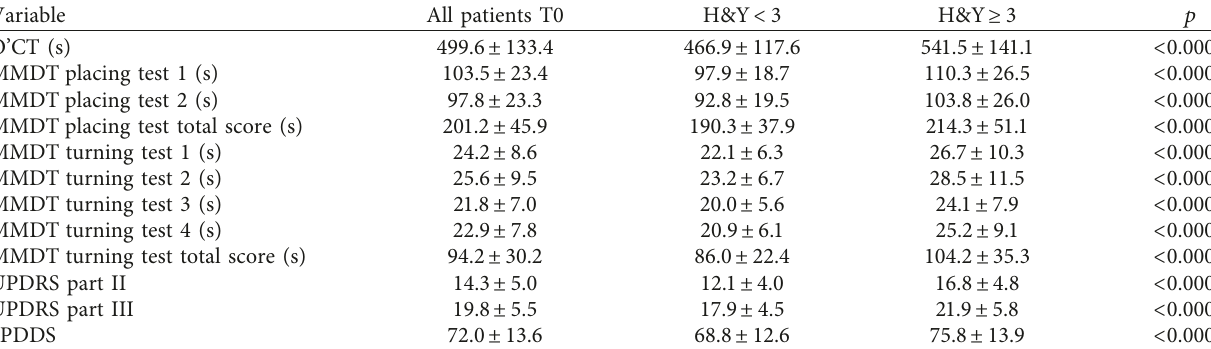
Table 2: Baseline values of the clinical, motor, and functional outcome variables for all patients as a whole and grouped in H&Y < 3 and in H&Y stage ≥ 3, with p values for between-group comparisons.